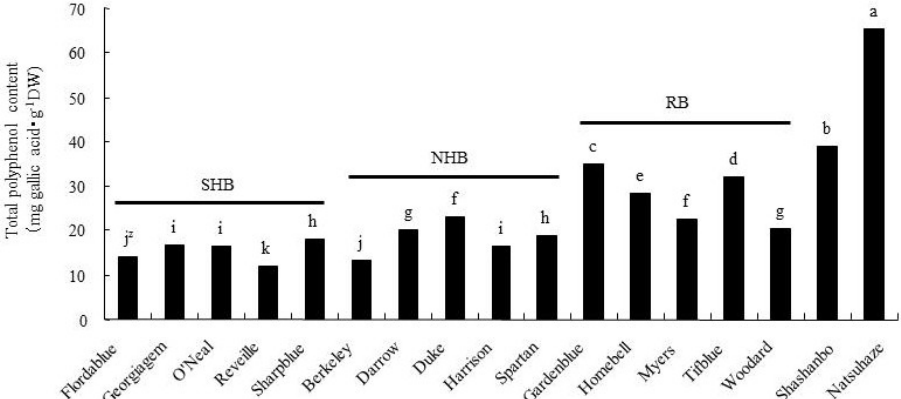
SHB: Southern highbush blueberry. NHB: Northern highbush blueberry. RB: Rabbiteye blueberry. Shashanbo ( Vaccinium bracteatum Thunb.) and Natsuhaze ( V. oldhamii Miq.). z Different letters represent significant differences in Tukey’s multiple range test, 1%